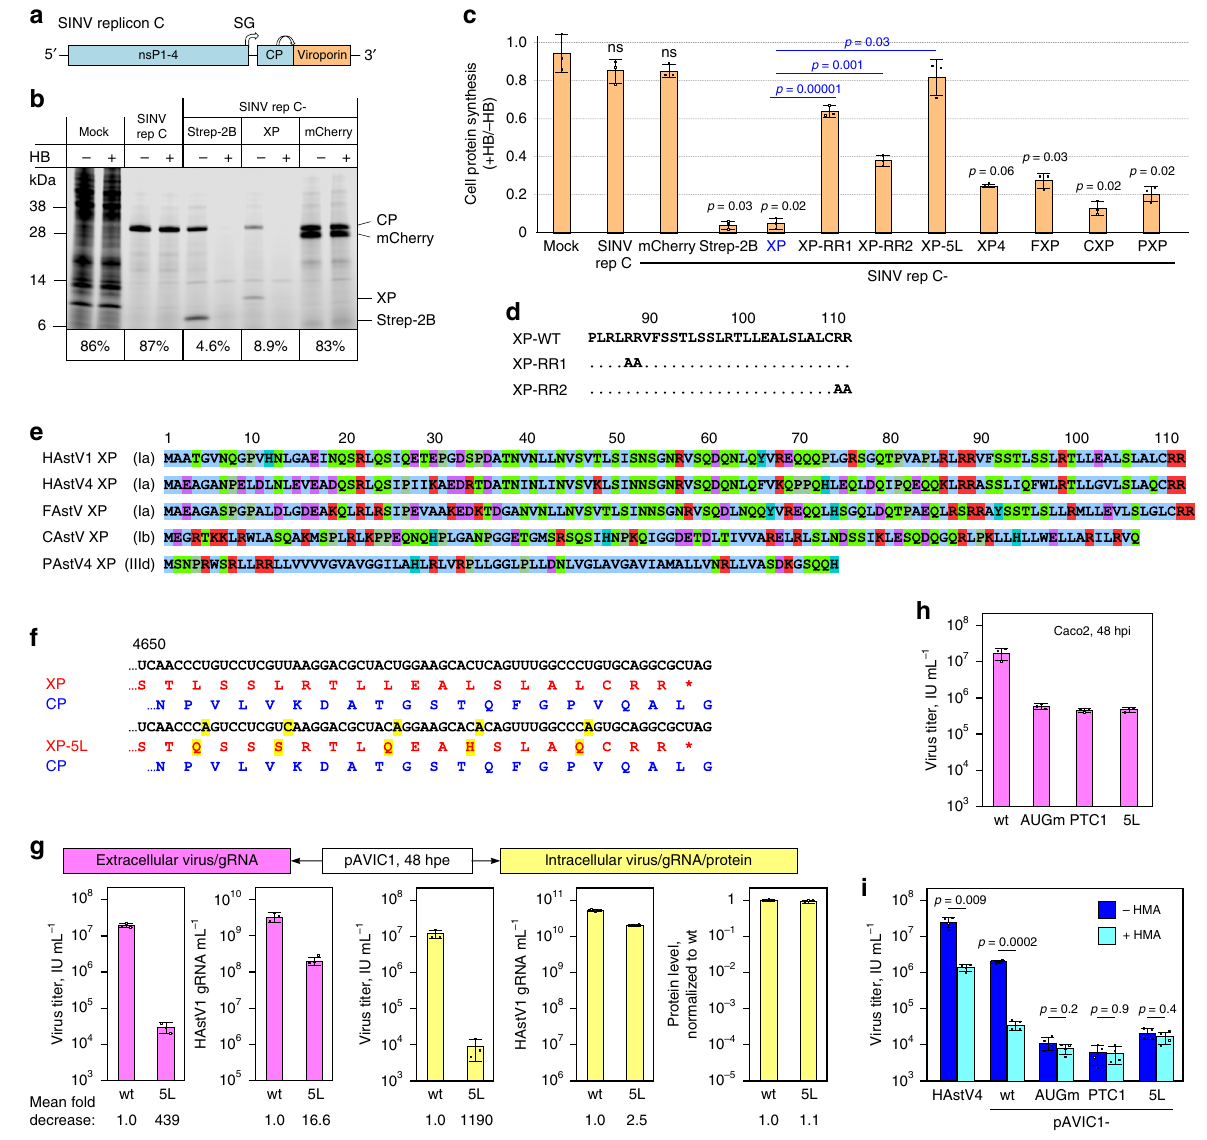
Fig. 6 XPs from different astroviruses have viroporin-like activity. a Schematic representation of SINV replicon C used to evaluate cell-permeabilizing activity of expressed proteins. SINV elements: nsP1-4 – non-structural polyprotein; CP – capsid protein; SG – subgenomic promoter. b Membrane permeabilization in BSR cells at 8 h post RNA electroporation with Sindbis virus replicons (SINV repC) expressing HAstV1 XP, enterovirus Strep-2B (positive control), or mCherry (negative control). Ongoing protein synthesis was labeled with 1 mM AHA in the presence or absence of 1 mM HB as a translation inhibitor. Cells were lysed and AHA-bearing proteins were ligated to the fl uorescent reporter IRDye800CW Alkyne by click chemistry, separated by SDS-PAGE, and visualized by in-gel fl uorescence. Numbers below each pair of samples indicate protein synthesis quanti fi ed for HB-treated cells relative to values obtained for untreated cells. c Statistical analysis of membrane permeabilization caused by different XPs and mutants and the indicated control proteins in BSR cells. Bars indicate the amount of protein synthesis in HB-treated cells relative to untreated cells. P values are from comparisons with mock (BSR; black) or with pSINV-repC-XP (blue). d Sequences of wt, RR1, and RR2 HAstV1 mutants. e Sequences of HAstV1, HAstV4, and feline (FAstV), canine (CAstV) and porcine (PAstV) astrovirus XPs. f Alignment of pAVIC1-wt and -5L showing translation of XP (red) and the overlapping CP (blue). Introduced nucleotide and amino acid changes are highlighted in yellow. g Quanti fi cation of virus titer, RNA, and protein levels in released virions and infected cells as described in Fig. 4g. h Caco2 cells were infected with the indicated viruses at MOI 0.2 and incubated for 48 h. Released virus in clari fi ed supernatants was titrated. i Caco2 cells were infected with the indicated viruses at MOI 0.2 in the presence (dark blue) or absence (light blue) of 5 µ M hexamethylene amiloride (HMA). Intracellular (HMA-free) virus was titrated. See Supplementary Fig. 20 for cell toxicity data. P values come from two-tailed t -tests without adjustment for multiple comparisons. Error bars indicate mean ± s.d.; n = 3 ( c , g , h ) or 4 ( i ) biologically independent experiments. Source data are provided as a Source Data fi released virus (439-fold), but not in intracellular levels of viral RNA and protein (Fig. 6g). Similar to the PTC1 mutant, the 5L mutant was also impaired in virus release in infected Caco2 cells (Fig. 6h), consistent with the viroporin-like activity of XP being important in virion formation and/or release.